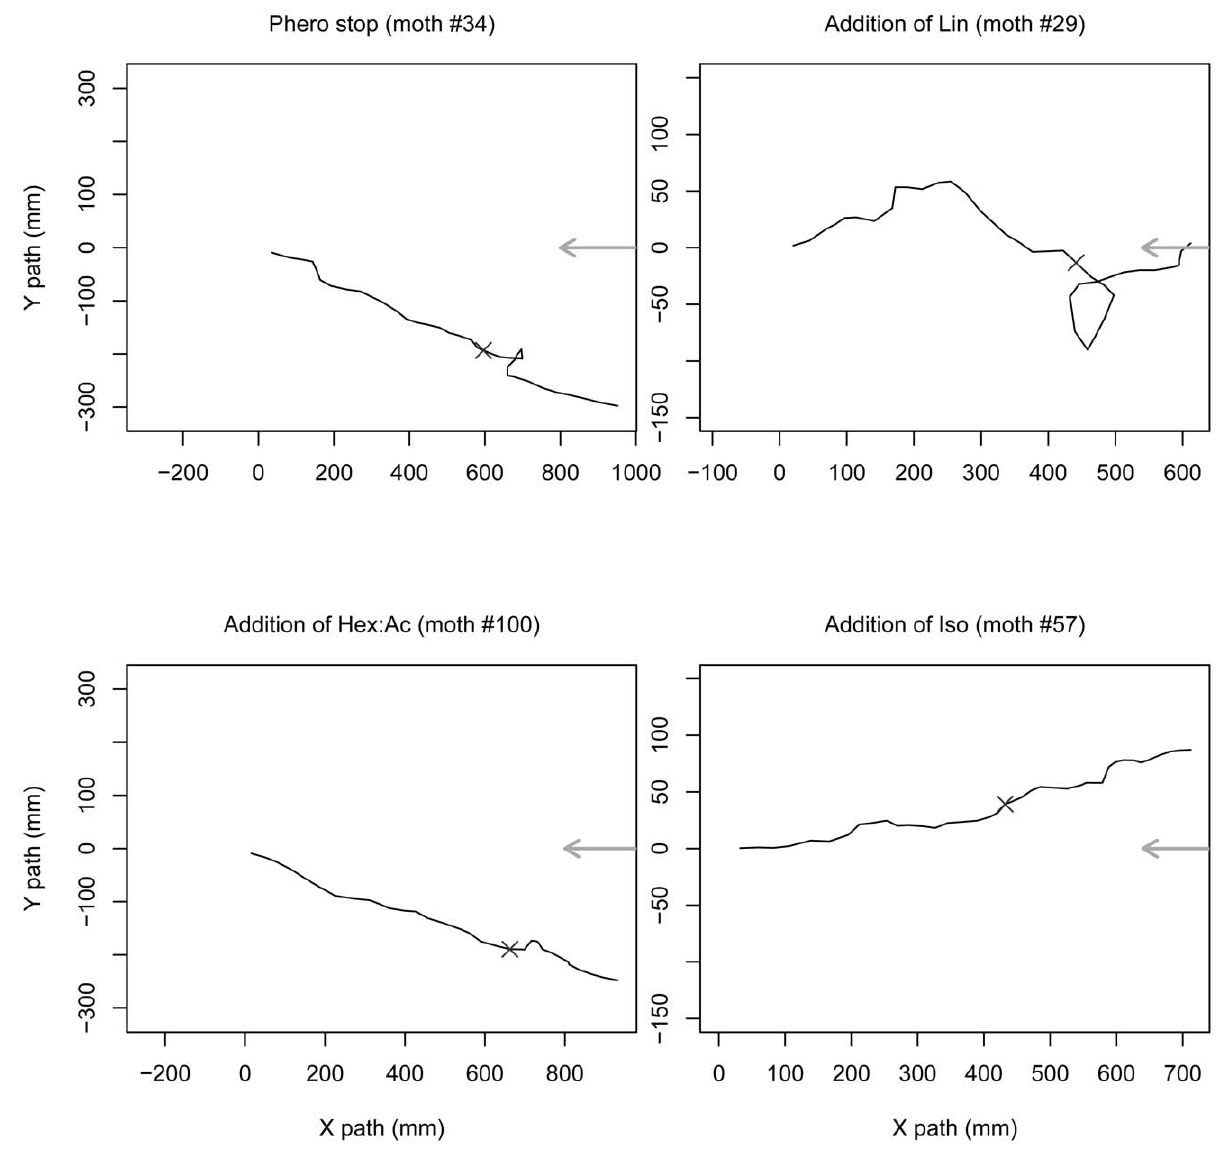
Figure 4. Changes in background modify the PWR. Examples of individual tracks that show the effects of changes in the odor background. Only the section of the whole track corresponding to the 40–80 s time window is presented. The background was changed at 60 s (cross). X- and Y- axes indicate the distance in mm. The direction of the air flow is indicated by the grey arrow. doi:10.1371/journal.pone.0052897.g004 responses to the switching from one channel to another because when we switched between two channels, delivering Phero at time = 60 sec, males did not change their speed, straightness or orientation index ( P= 0.50, 0.82 and 0.22, respectively (data not shown).